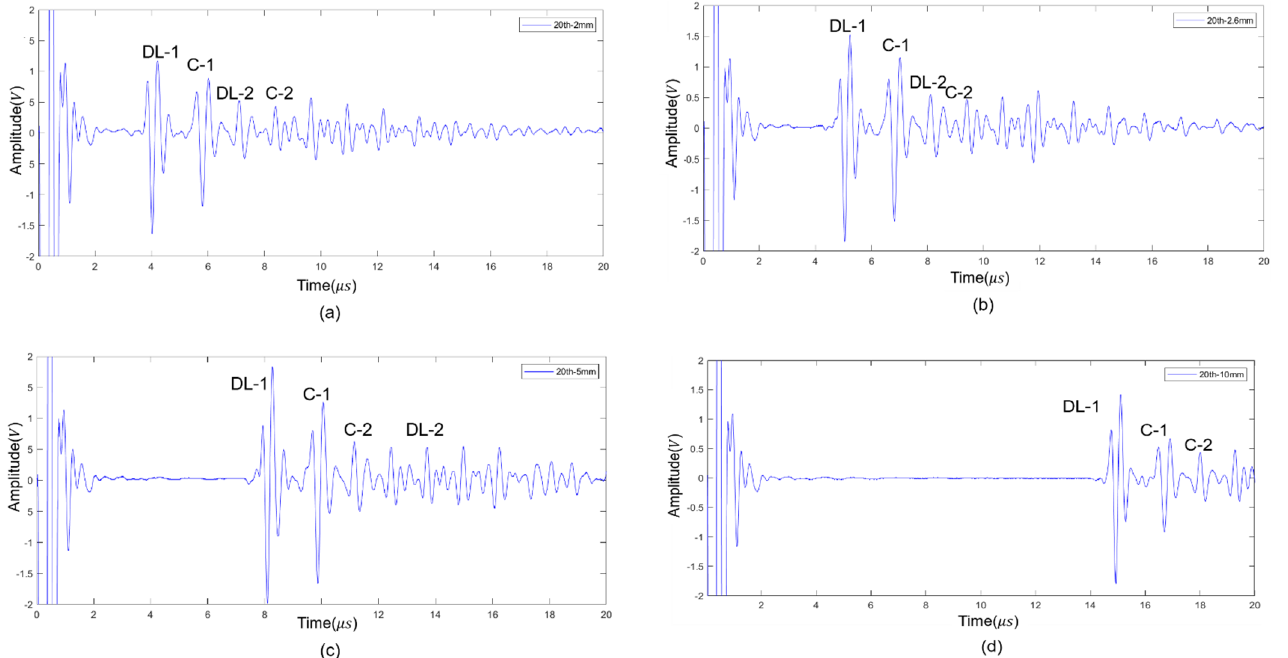
Figure 4. Experiment results. The 20th area coating material thickness measured: ( a ) Water delay line 2 mm, ( b ) Water delay line 2.6 mm, ( c ) Water delay line 5 mm, and ( d ) Water delay line 10 mm